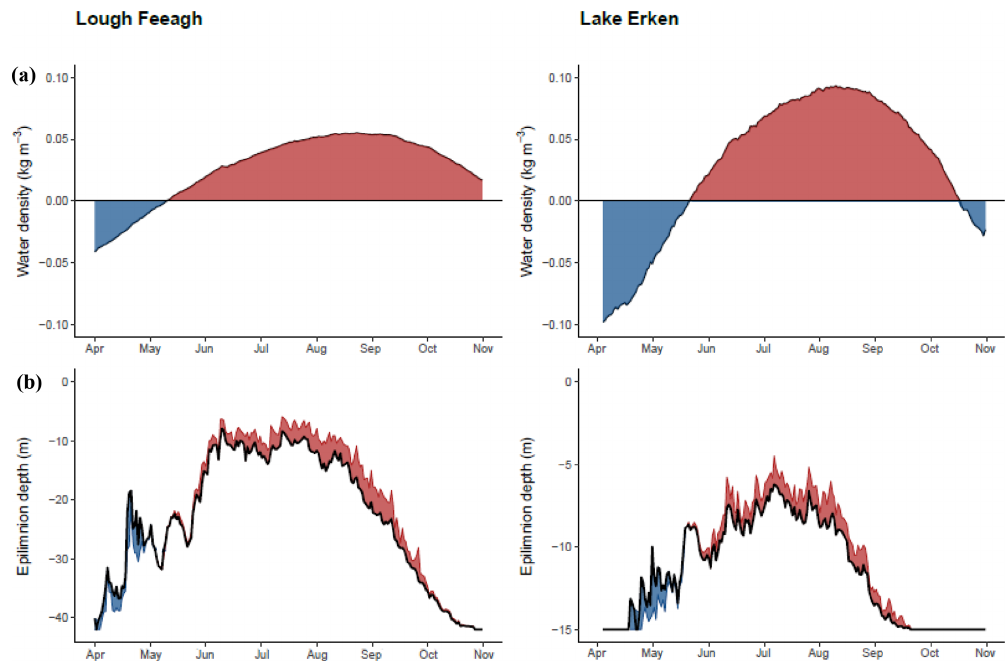
Figure 3. Long-term mean for each Julian day of the difference in water density (kgm − 3 ) induced by an increase of 1 ◦ C in water tem- perature, relative to 0.1kgm − 3 (black line with the red shaded area demonstrating when the change induced by an increase of 1 ◦ C change was greater than 0.1kgm − 3 and the blue shaded area for when it was less than 0.1kgm − 3 ) (a) . The long-term mean for each Julian day of epilimnion depth calculated using a water temperature threshold of 1 ◦ C (the black line) compared to a water density threshold of 0.1kgm − 3 (shaded area, with the red shaded areas demonstrating when water density estimates were shallower and the blue shaded area for when they were deeper) (b) for Lough Feeagh and Erken